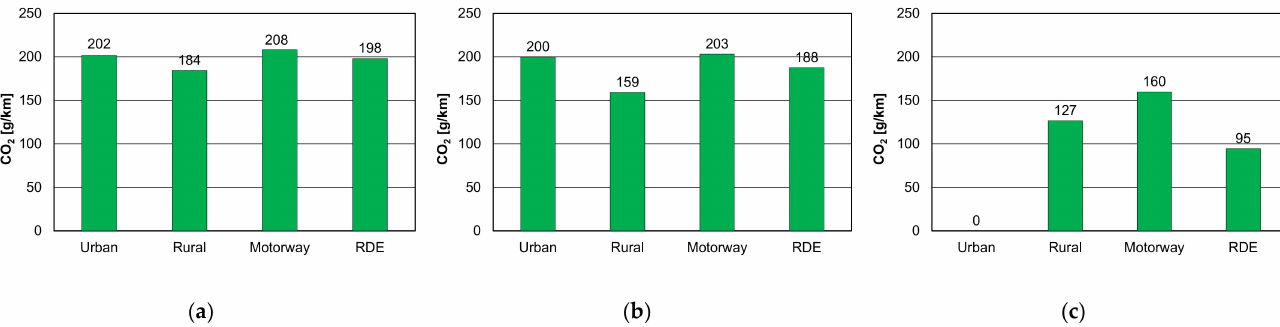
Figure 8. Results of tests of carbon dioxide on-road emission in a passenger vehicle with a gasoline engine ( a ), a diesel engine ( b ), PHEV ( c ).